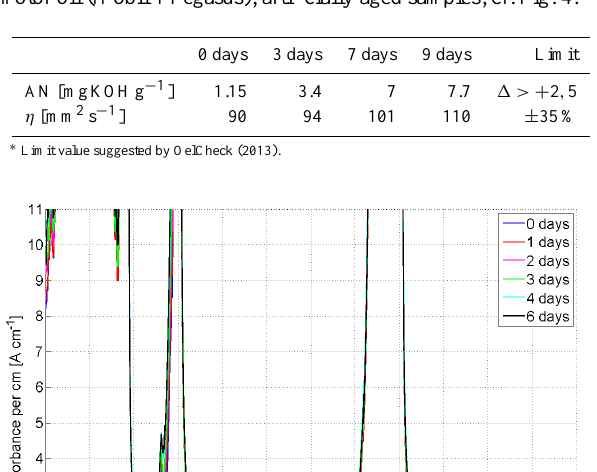
reaches the recommended threshold limit of the kinematic viscosity after only 3 days of artificial aging, see Table 5.